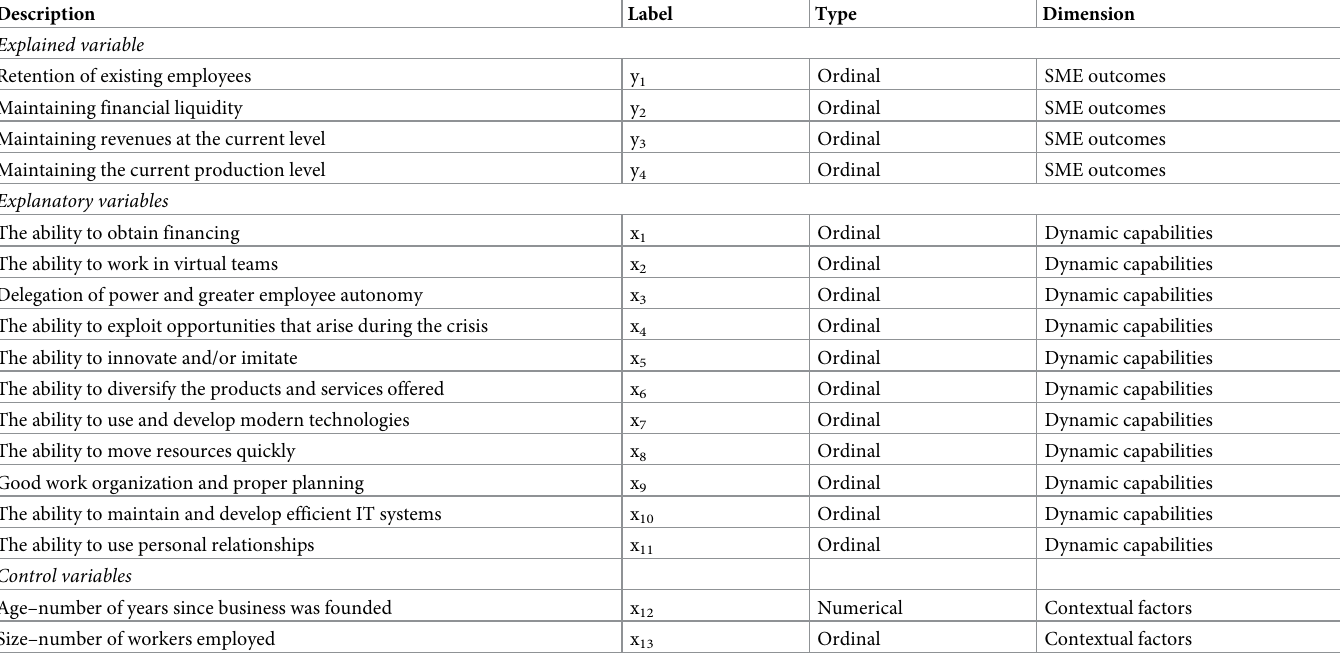
Table 3. Summary of